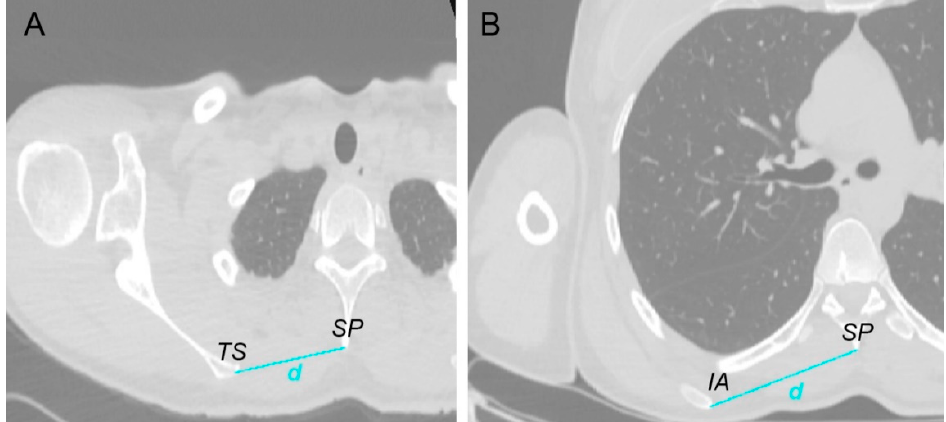
Figure 2. Measurement of the scapula positioning relative to the thorax using computed tomography (CT) images: ( A ) shortest distance d between the most medial point of the trigonum spinae ( TS ) of the scapula and the adjacent spinous process ( SP ); ( B ) shortest distance d between the most medial point of the inferior angle ( IA ) of the scapula and the adjacent spinous process ( SP ).